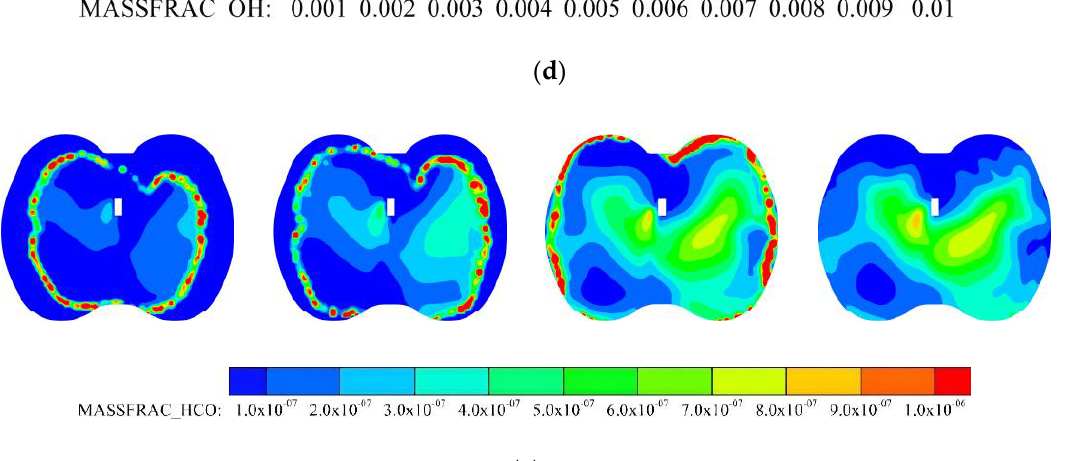
Figure 6. The mass fraction distribution of ( a ) IC 8 H 18 , ( b ) H 2 O 2 , ( c ) CH 2 O, ( d ) OH and ( e ) HCO in the cylinder (CR = 10.3, ignition time = − 14 degCA).